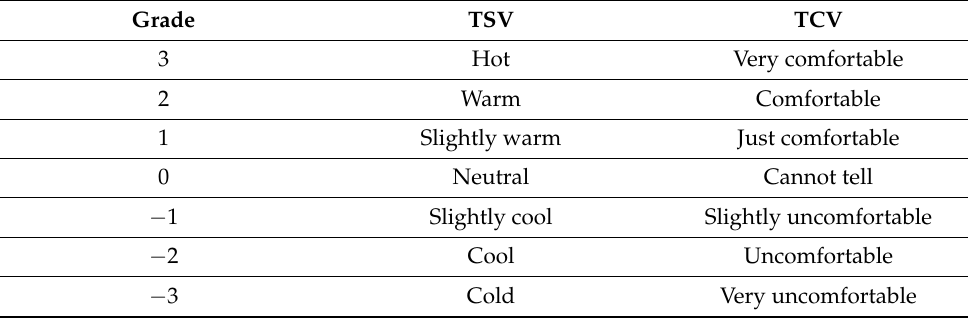
Table 2. Seven-grade scale employed in the present study.